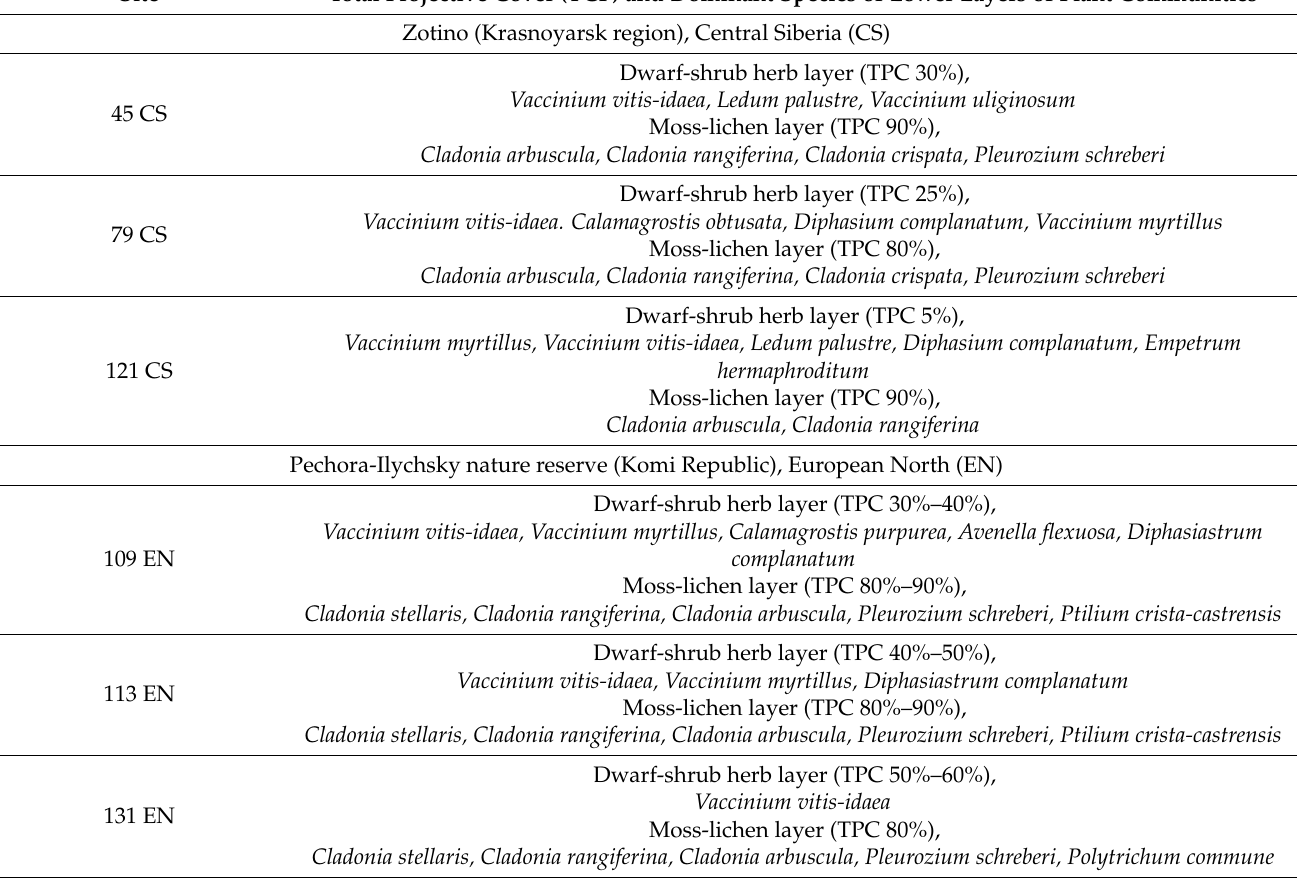
Table 1. Total projective cover (TCP) and dominant species of the lower layers of plant communities of Pinetum vaccinioso-cladinosum formed on albic podzols.